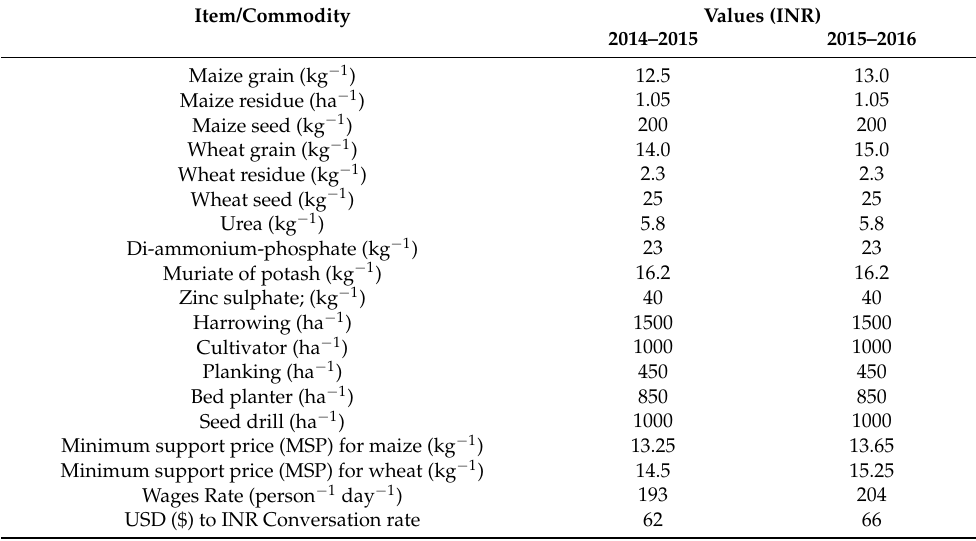
Table 3. Values of key inputs and outputs used for economic analysis in 2014–2015 and